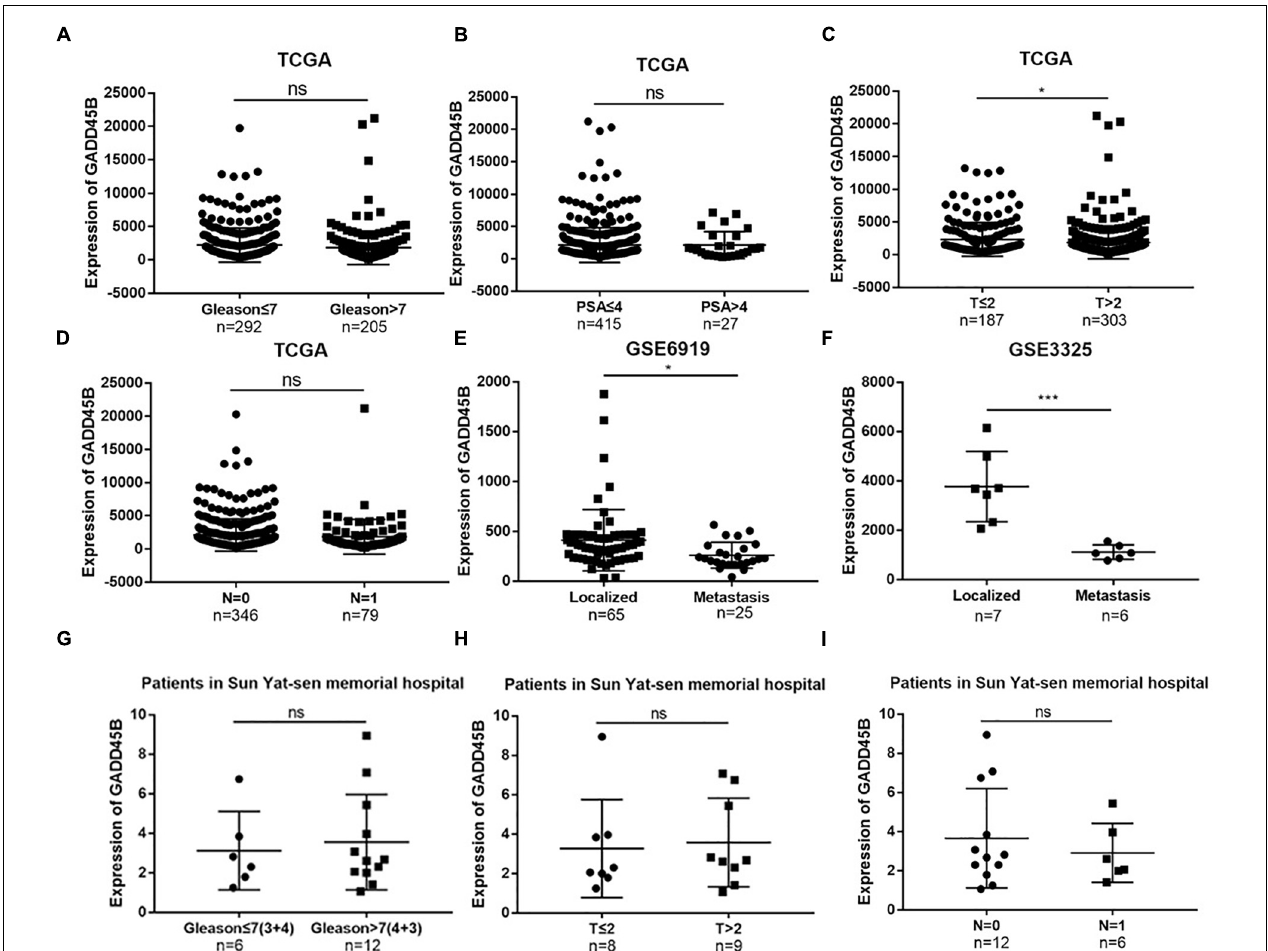
FIGURE 1 | TCGA, GEO database, and clinical samples identified GADD45B correlated with the metastasis of PCa. (A–D) Correlation of GADD45B expression with clinical features of PCa patients in the TCGA dataset. (E,F) Correlation of GADD45B expression with metastatic PCa datasets from GEO. (G–I) Correlation of GADD45B expression with clinical features of PCa patients from Sun Yat-sen Memorial Hospital. * p < 0.05, *** p < 0.001, and not statistically significant p > 0.05.